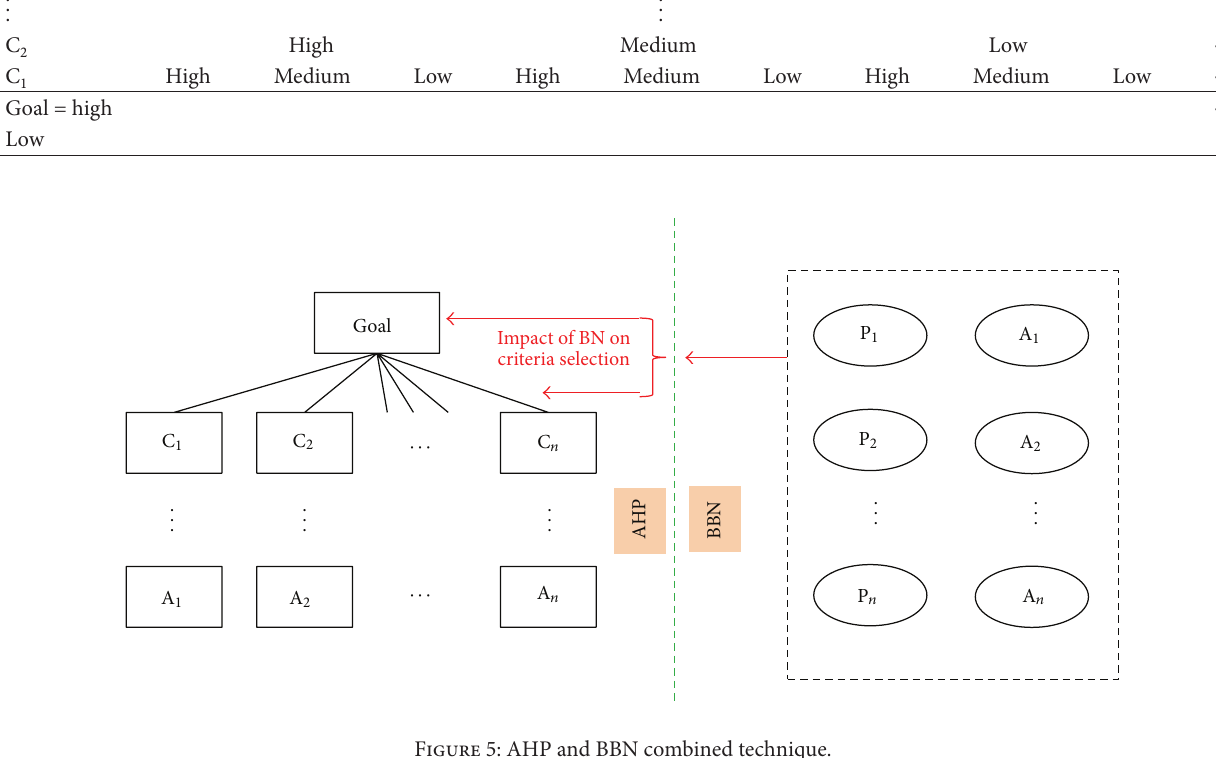
Figure 5: AHP and BBN combined